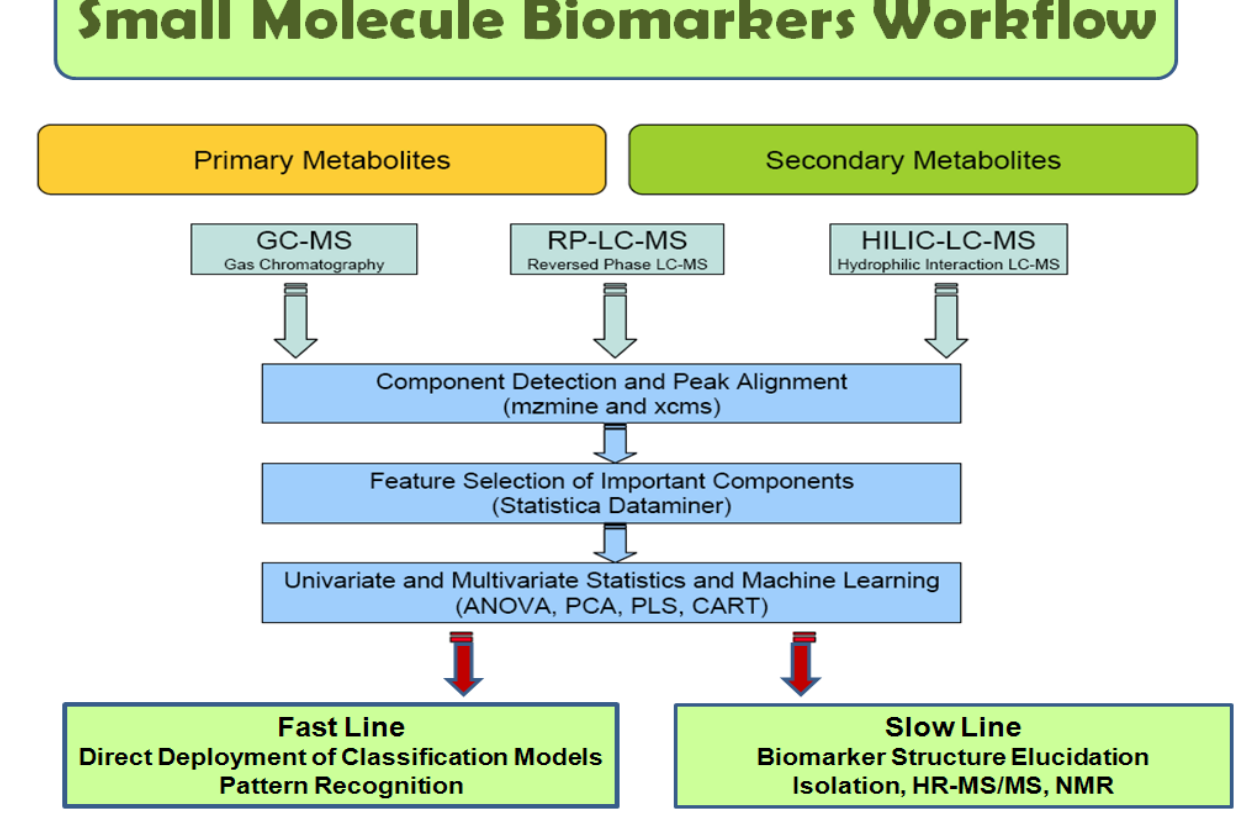
Figure 1. Small Molecule Analysis Workflow at UC Davis Metabolomics